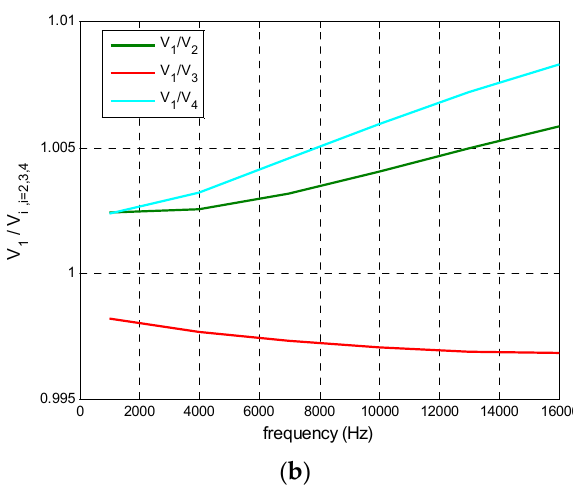
Figure 21. ( a ) Voltage ratios between channels; ( b ) Behaviour of these ratios with frequency.